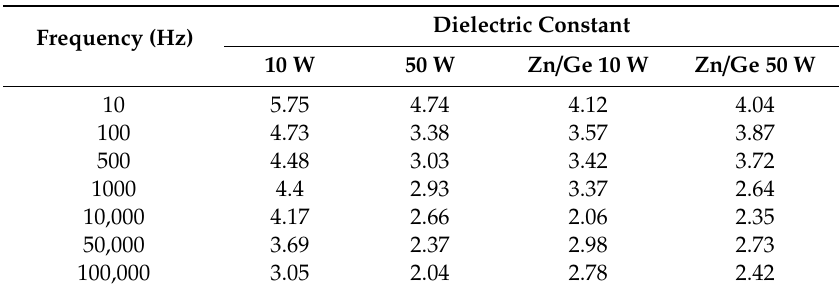
Table 1. The dielectric constants of pristine and composite polymer coatings manufactured at 10 W and 50 W.